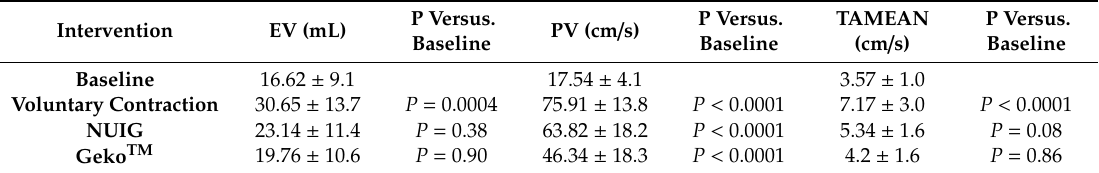
Table 1. Summary of results from all interventions and parameters measured. P Versus. Baseline